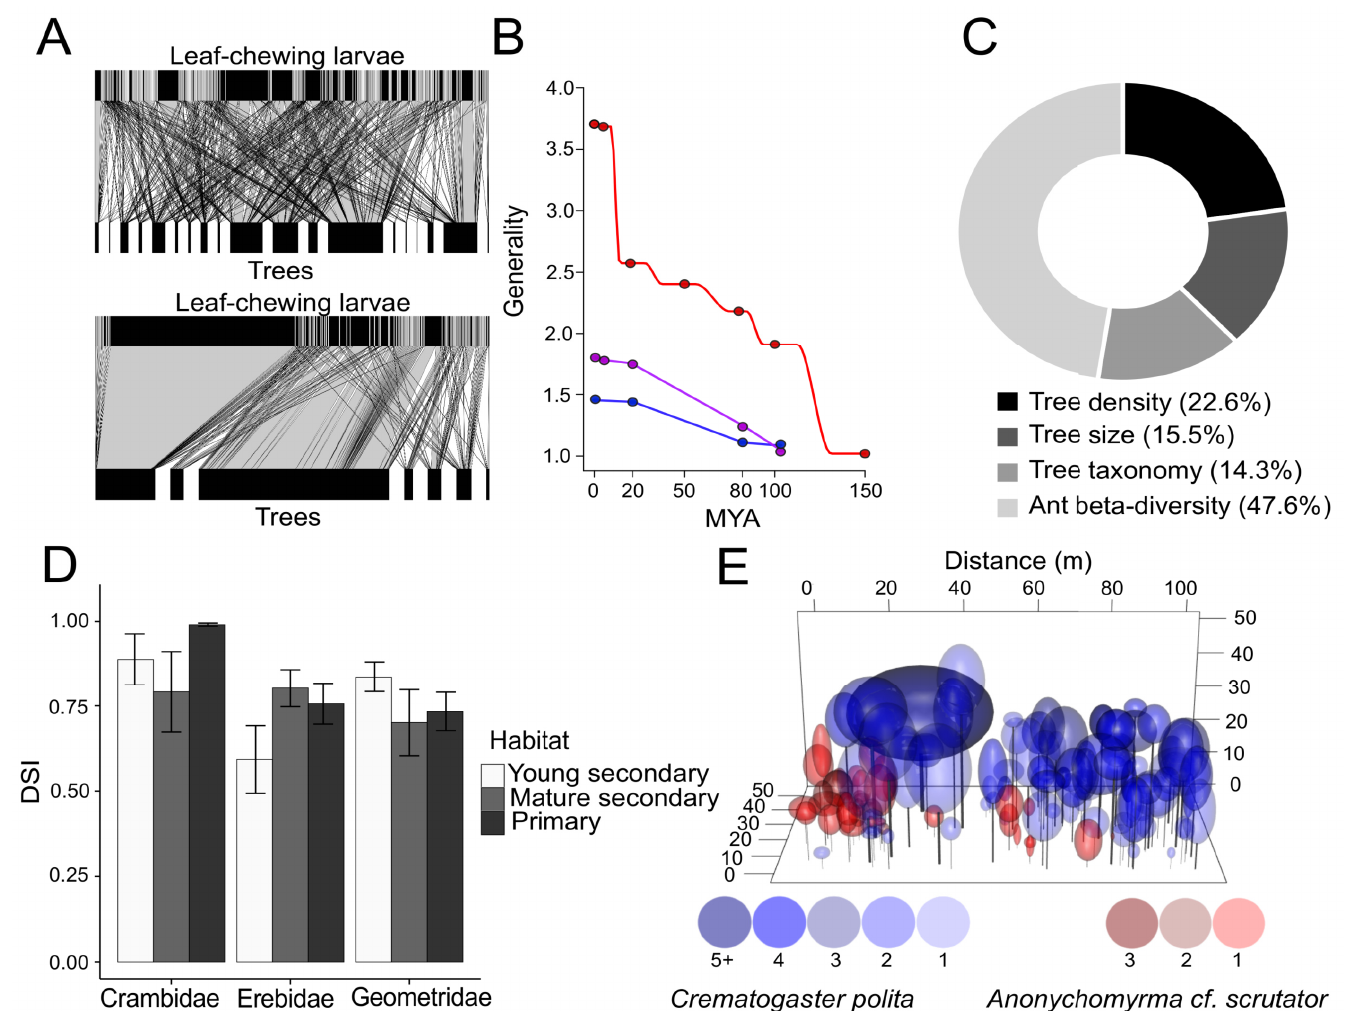
Fig 4. Example results from plot-based sampling. Construction of comparable quantitative interaction networks (A: plant-caterpillar food-webs from two 0.1 ha plots with contrasting herbivore and tree diversity; based on data from Volf et al. [21]). Such networks can be used to quantify effects of plant traits or phylogeny on arthropod communities (B: effects of host phylogeny on caterpillar food-webs quantified by change in generality from herbivore data collated according to the time of divergence of their hosts (in Tomakomai (red), Lanzhot (purple), Mikulcice (blue)); based on data from Volf et al. [21]). The relative contribution of such effects can be decomposed, allowing the prediction of arthropod community composition (C: the proportional difference in total ant species richness between primary and secondary forest in Wanang due to the effects of vegetation composition and species turnover; based on data from Klimes et al. [28]). Furthermore, standardized measures of herbivore specialization can be made, enabling meaningful comparisons across habitats and taxa with variable phylogenetic diversity and plant abundance (D: mean Distance Based Specialisation Index (DSI � ) +/- SE for Crambidae, Erebidae, and Geometridae along a successional gradient in Yawan; based on data from Redmond et al. [23]. Finally, we can analyse spatial patterns in canopy arthropod communities (E: distribution of tree canopy nest density in the two most abundant ant species in 0.4 ha of Wanang forest (only trees with nests are shown); based on Klimesˇ and Mottl ( unpublished data